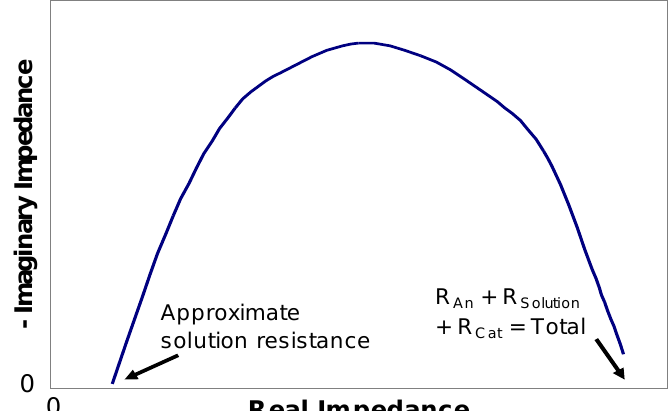
Figure 3. Typical Nyquist plot for an MFC. Notations indicate points for estimation of R and total Solution